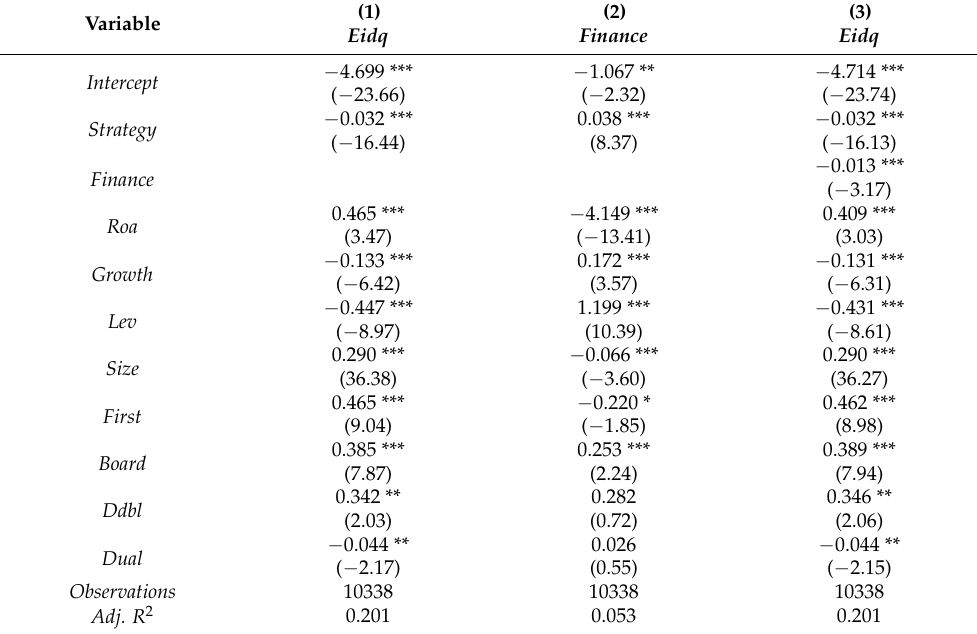
Table 11. Business strategy, financing constraints and environmental information disclosure